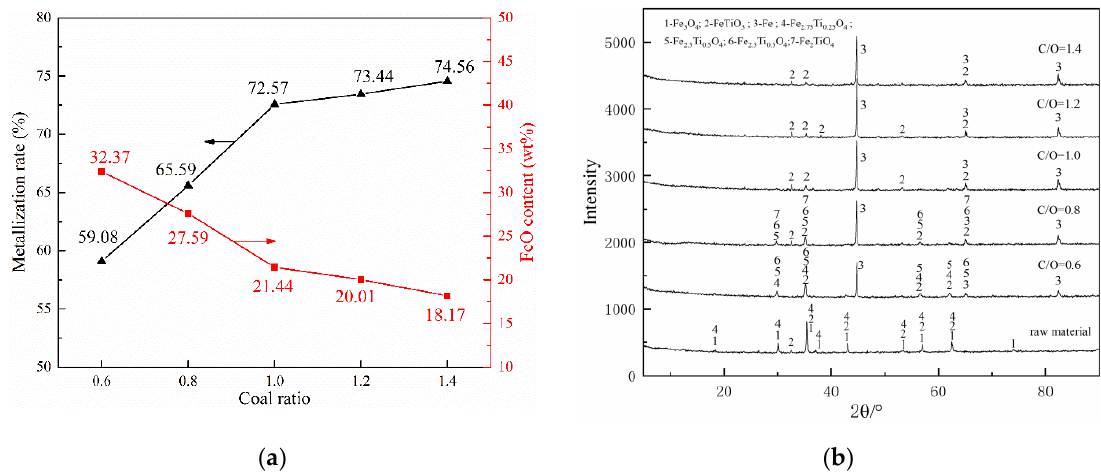
Figure 6. Effects of coal ratio on composite’s behaviors: ( a ) metallization ratio and FeO content and ( b ) phase